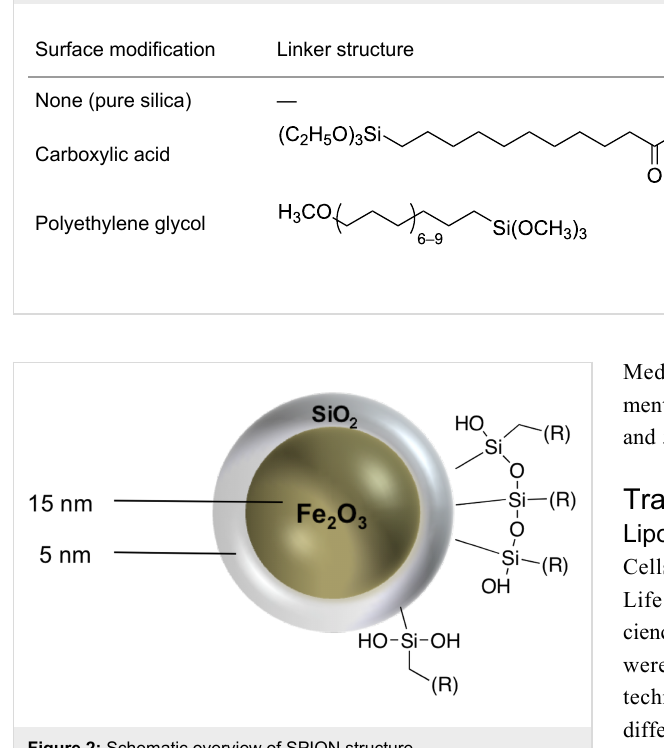
Table 1: Surface modification of SPIONs and their physical properties at room temperature in aqueous dispersion (pH 7, DLS = dynamic light scat- tering).